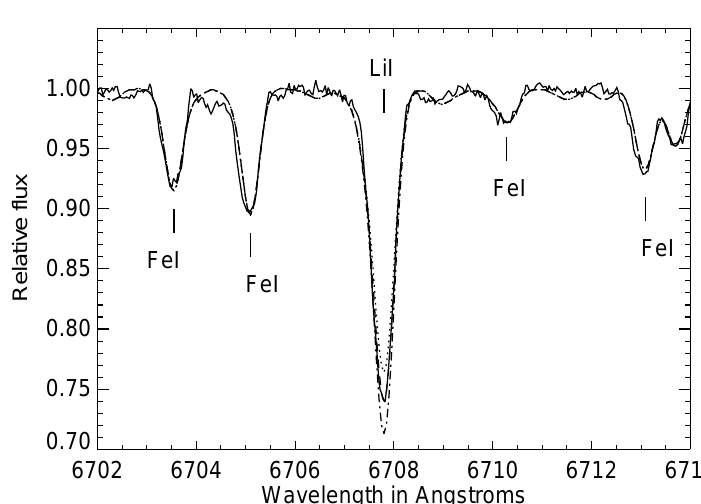
Fig. 2. The observed and the synthetic spectra of HD 377 with three different Li abundances: log ε (Li) = 2 . 95 (dotted line), log ε (Li) = 3 . 02 (dashed line) and log ε (Li) = 3 . 10 (dash-dotted line). The abundance 3.02 fits the observed spectrum